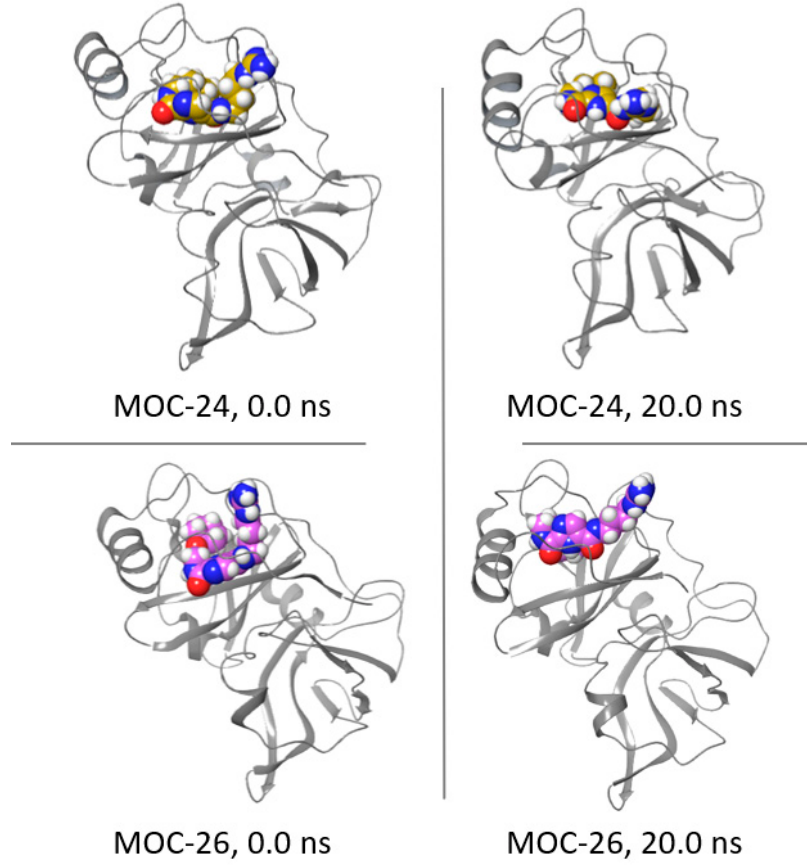
Figure 9. Change in the positioning of MOC-24 (upper, ligand colored golden yellow) and MOC-26 (lower, ligand colored magenta). The right images are for protein-ligand (PL) complexes before the start of the MD simulations and the left two images are for PL complexes after completion of the MD simulations.